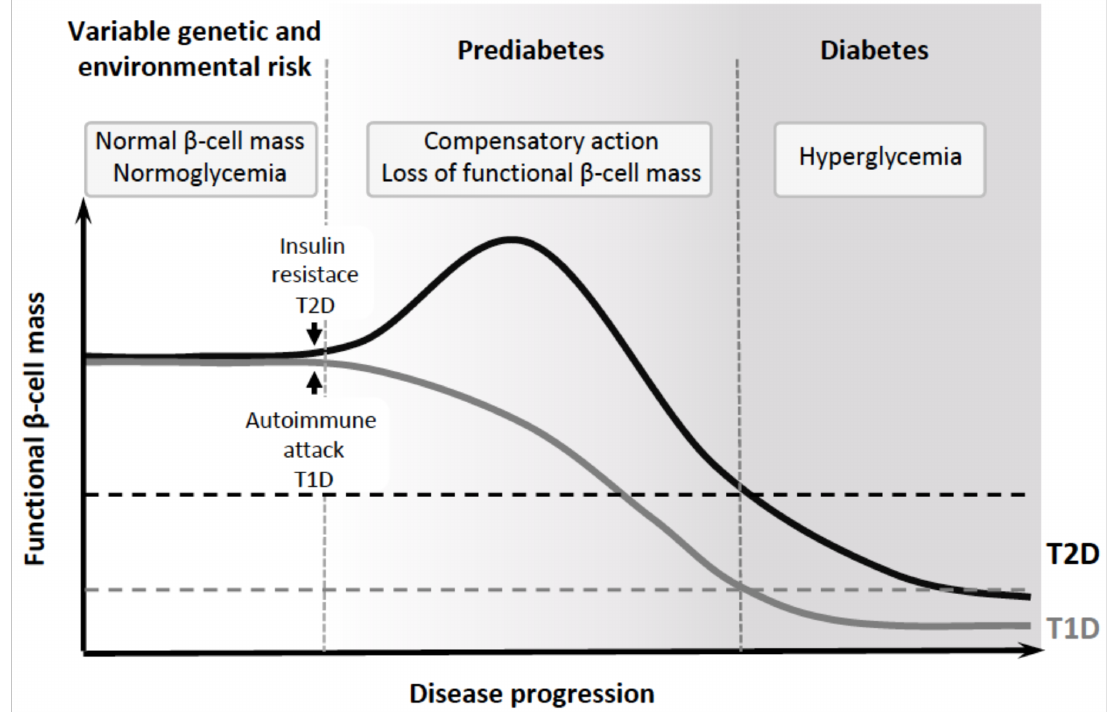
Figure 1. Diabetes progression stages. Diabetes is a continuum that is not clinically symptomatic until the levels of functional β -cell mass are below a threshold (dash line) that disables the capacity of the islets to compensate for the insulin demand. However, the alterations in the functional β -cell mass appear at earlier stages, before the onset of